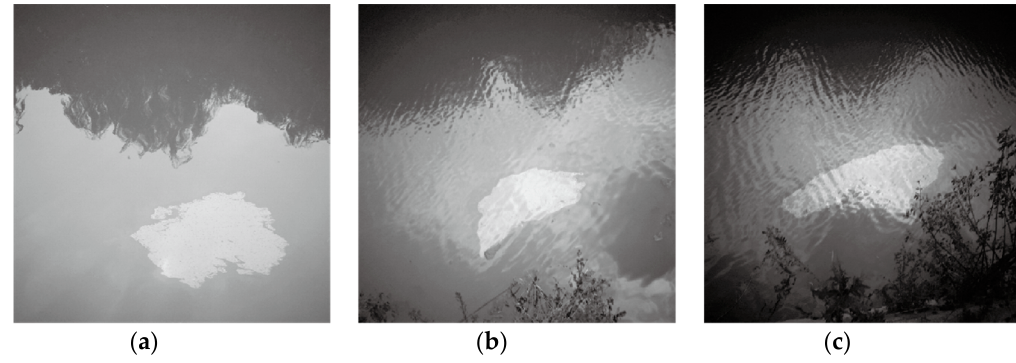
Figure 4. Examples of chemical spill targets in UV images. ( a ) Image with shadow; ( b ) image with shadow, wave, and sun reflection; ( c ) image with shadow, wave, and sun reflection;Since a complex background is not conducive to the precise segmentation of the target, we propose a global background suppression (GBS) algorithm to subtract the redundant information from the background. The main idea of the algorithm is to estimate an adjustable threshold based on the intensity distribution, and then to filter the pixels that are less than the threshold in the images. The details are described as follows.